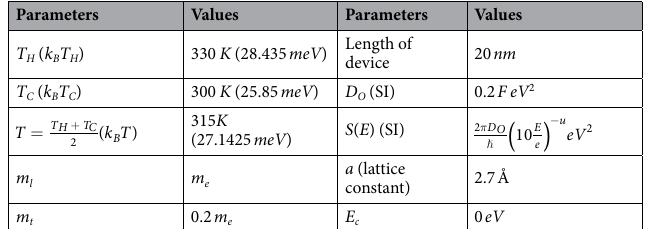
Table 1. Parameters used for simulation in this paper. Note : “SI” = supplementary information. = F and N y being the number of lattice points in the x and y directions with electronic transport being in the z − direction. The parameter u is related to the order of scattering process ‘ − r ’ by the equation = − + u r 1 nanowires and = − − u r 1 for bulk generators. u = 0 for acoustic phonon scattering. m e is the free electron 2 mass and D O is related to the acoustic deformation potential (see supplementary